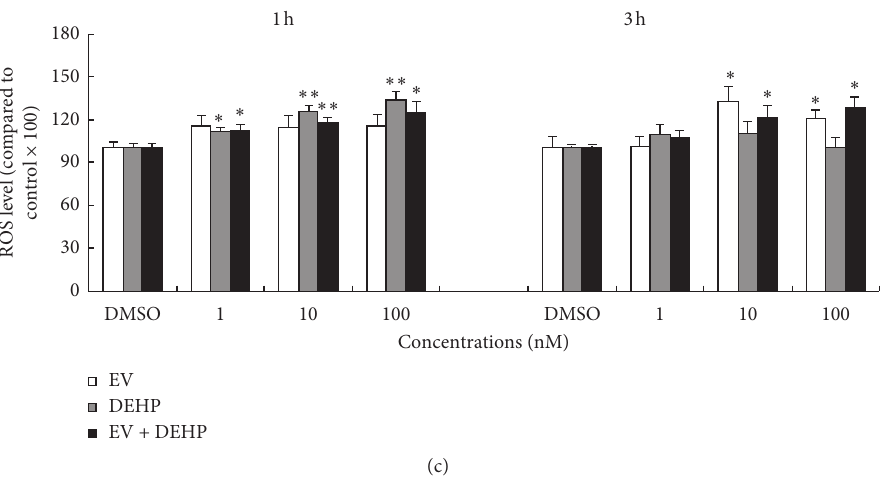
Figure 6: The binary joint effects of tested compounds and EV on the intracellular ROS generation in MCF-7 cells. A binary joint system of (a) DES and BPA; (b) BPA and EV; (c) DEHP and EV. Data points represent mean ± SD of three independent experiments. ∗ p < 0 . 05, ∗∗ p < 0 . 01, compared with DMSO; # p < 0 . 05, ## p < 0 . 01, compared with EV treatment.